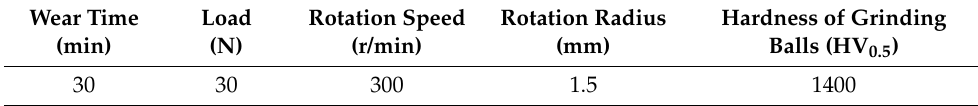
Table 4. The experimental parameters of wear tests.